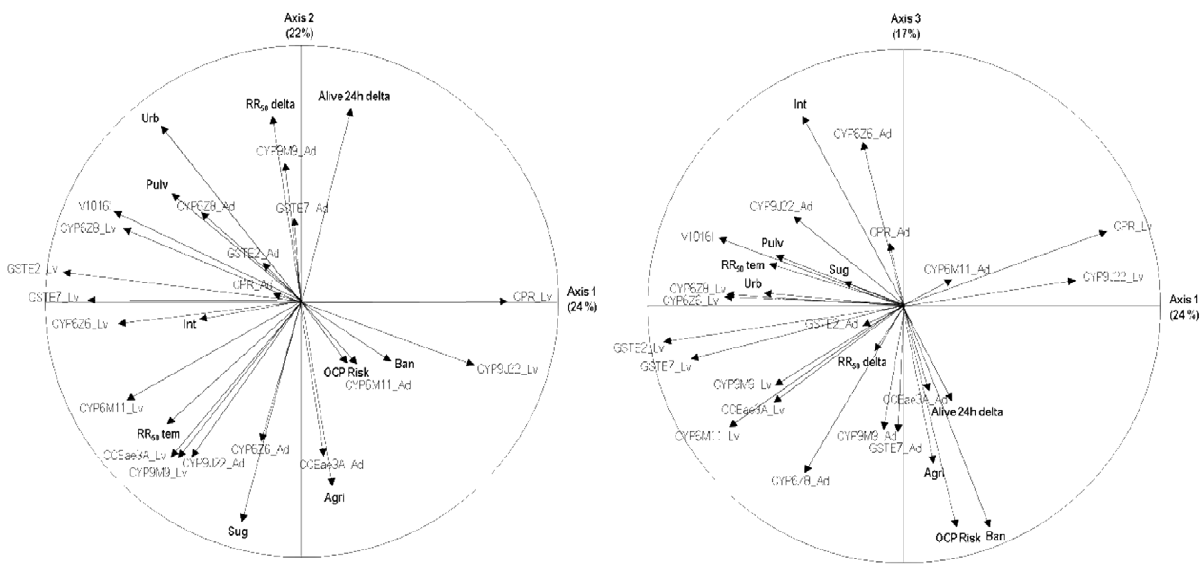
Figure 4. Graphical representation of the 29 variables on the three first axes of the principal component analysis (PCA). Percent of starting information represented by each PCA axis are indicated. Variables related to insecticide resistance levels and environment are shown in bold. V1016I: % V1016I Kdr mutation; RR 50 delta: RR 50 to deltamethrin knock down effect; Alive 24 h delta: % alive adult mosquitoes 24 hours after deltamethrin exposure ; RR 50 tem: larval RR 50 to temephos; Pulv: deltamethrin thermal fogging application events from 2006 to 2009; Int: Insecticide treatments intervention events from 2006 to 2009; Urb, Agri, Ban, Sug: % land surface of urbanization, agriculture, bananas and sugar culture respectively around each population; OCPs Risk: organochlorine pollution (mainly chlordecone and lindane). [15,41]. The over-transcription of CYP6Z6 and CYP6Z8 in most Martinique populations confirms the possible involvement of Ae.